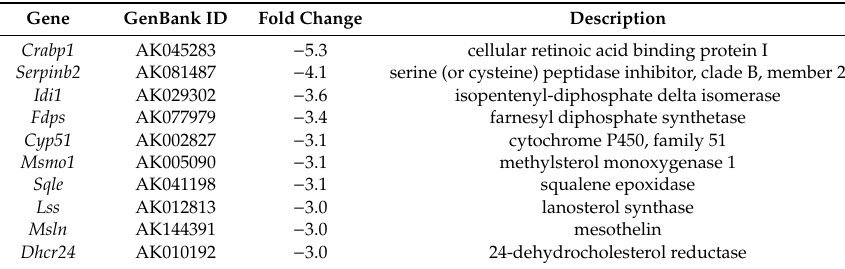
Table 3. Top 10 down-regulated genes in TLE3 knockdown in TM4